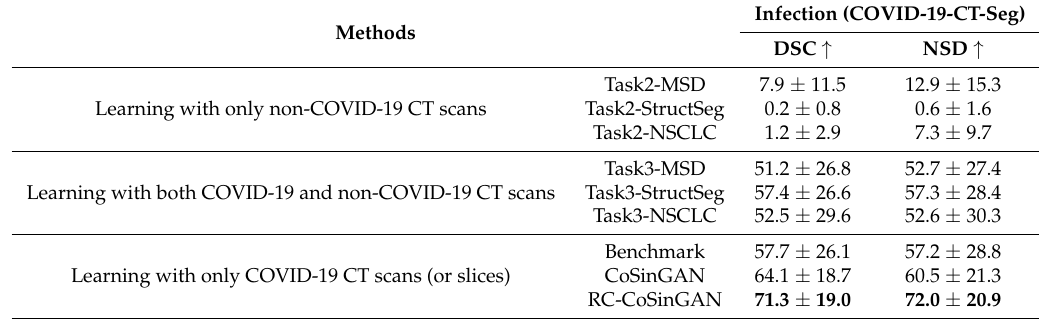
Table 7. Quantitative results (Mean±Standard deviation) of different solutions for learning automated COVID-19 infection segmentation based on 2D U-Net. ↑ denoting a higher score admits better segmentation performance. The entries in bold highlight the best average